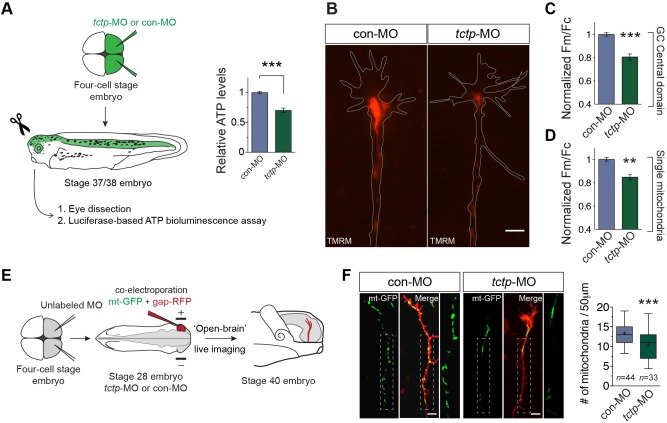
Compromised mitochondrial homeostasis in axons deficient for Tctp. (A) Relative ATP levels per retina normalised to total protein. Mean±s.e.m.; n=17 per condition, ***P<0.0001, unpaired t-test. (B) Representative RGC growth cones loaded with TMRM from con-MO-injected and tctp-MO-injected embryos. (C) Quantification of TMRM fluorescence intensity in the mitochondria-rich growth cone (GC) central domain. Mean±s.e.m.; ***P=0.0002, Mann–Whitney test. (D) Quantification of TMRM fluorescence intensity of individual mitochondria along the axonal compartment. Mean±s.e.m.; **P<0.0012, Mann–Whitney test. Up to ten replicate experiments were performed per condition, totalling 427 growth cones and 4918 single mitochondria analysed. (E) Schematic of the approach used to examine mitochondrial density in RGC axons in vivo. (F) Micrographs of RGC axons co-labelled with mt-GFP and gap-RFP, plus quantification of axonal mitochondrial density. n, number of axons analysed; ***P=0.0002, unpaired t-test. In box plots, whiskers cover 5th-95th percentile and ‘+’ indicates the mean. Boxed areas in images are enlarged to the right. Scale bars: 5 μm.